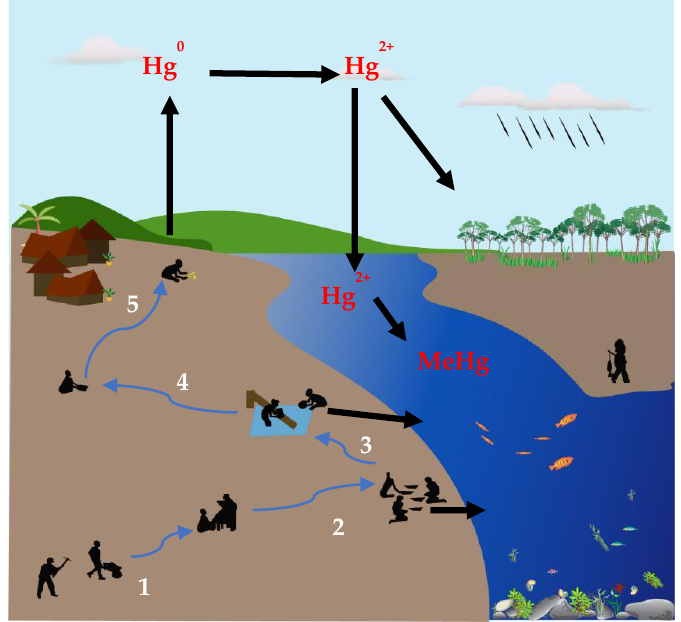
Figure 4. General ASGM processes involving (1) excavation, (2) grinding and sifting, (3) washing, (4) panning, and (5) gold – Hg-amalgam burning.